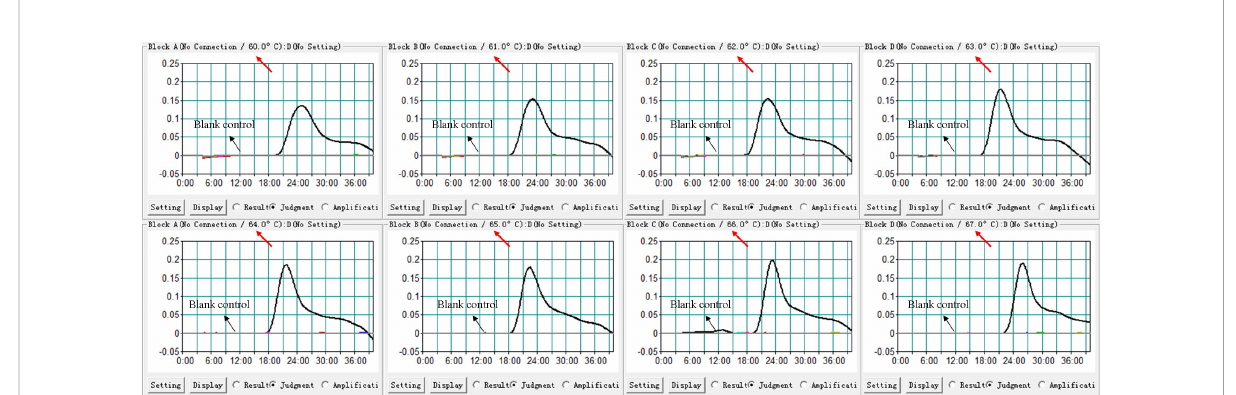
FIGURE 3 Temperature optimization for H. in fl uenzae-real-time MCDA assay. MCDA reactions detecting H. in fl uenzae were conducted using real-time turbidimeter, and the kinetic curves at different temperatures ranging from 60 to 67°C were acquired, showing that 63°C was the optimal temperature.